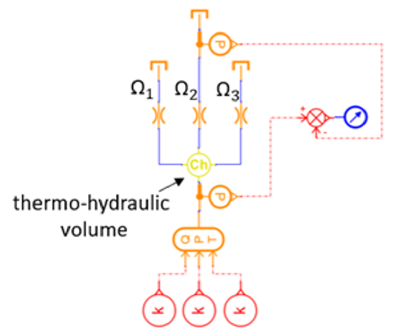
Figure 8. Manifold lumped parameter model.